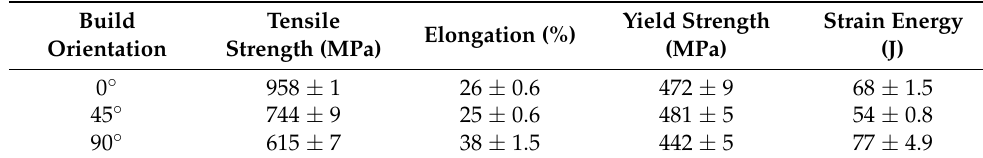
Table 3. Mechanical properties for three different build orientations.